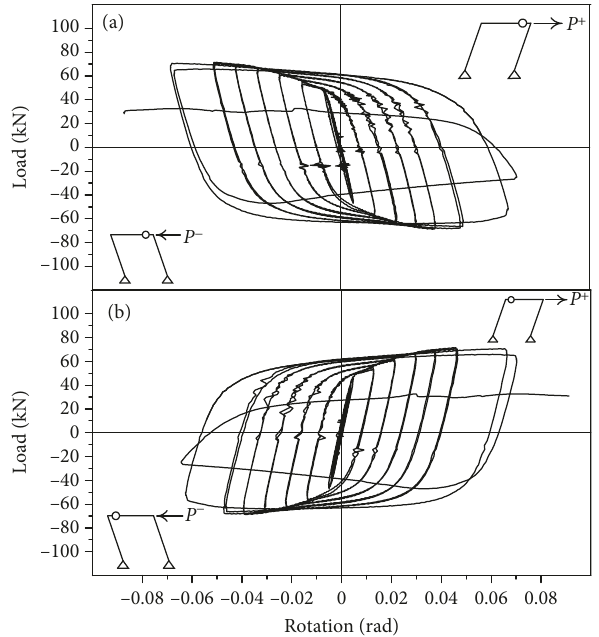
Figure 13: Load vs plastic hinge rotation of specimen PS-HS. (a) Right plastic hinge rotation ( θ